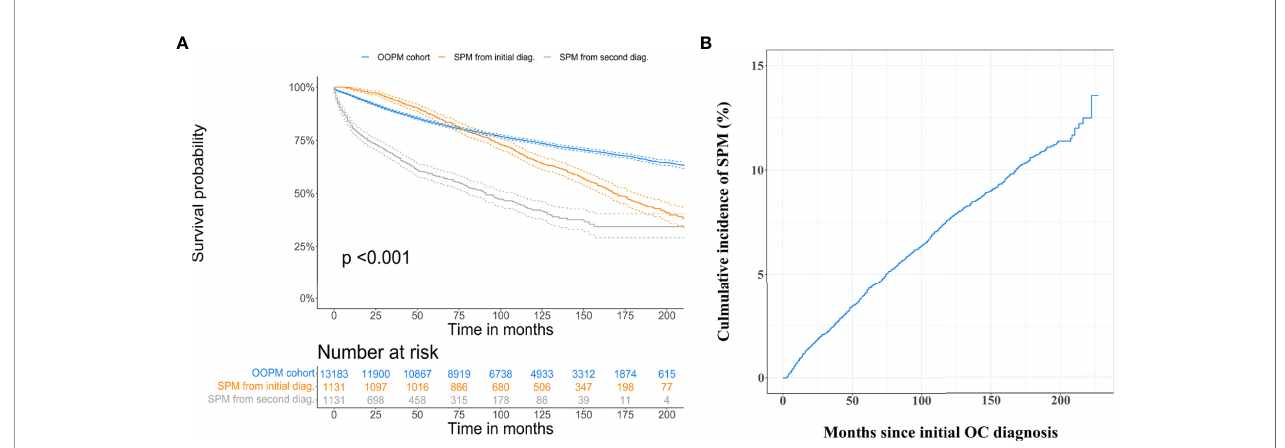
FIGURE 1 | Estimation of overall survival and cumulative incidence of developing second primary malignancies (SPMs). (A) Overall survival curves for only one primary malignancy cohort, for the SPM cohort from initial malignancy diagnosis, and second malignancy diagnosis. (B) Overall cumulative incidence curve for early- stage ovarian cancer patients developing SPMs after their initial diagnosis, treating non-SPM death as a competing